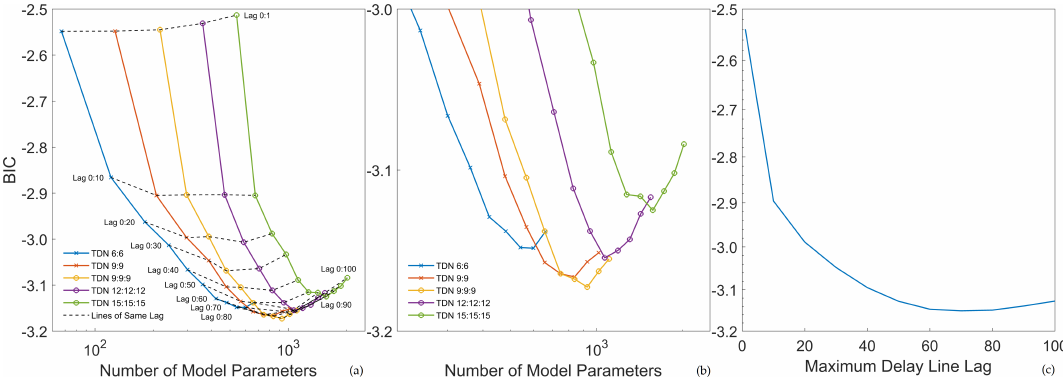
Figure 8. BIC model selection for Einthoven ECG lead estimation, TDNNs only: ( a ) Selection of models and lines of constant lag length. ( b ) Minimum BIC values. ( c ) BIC over the number of delay line lags.